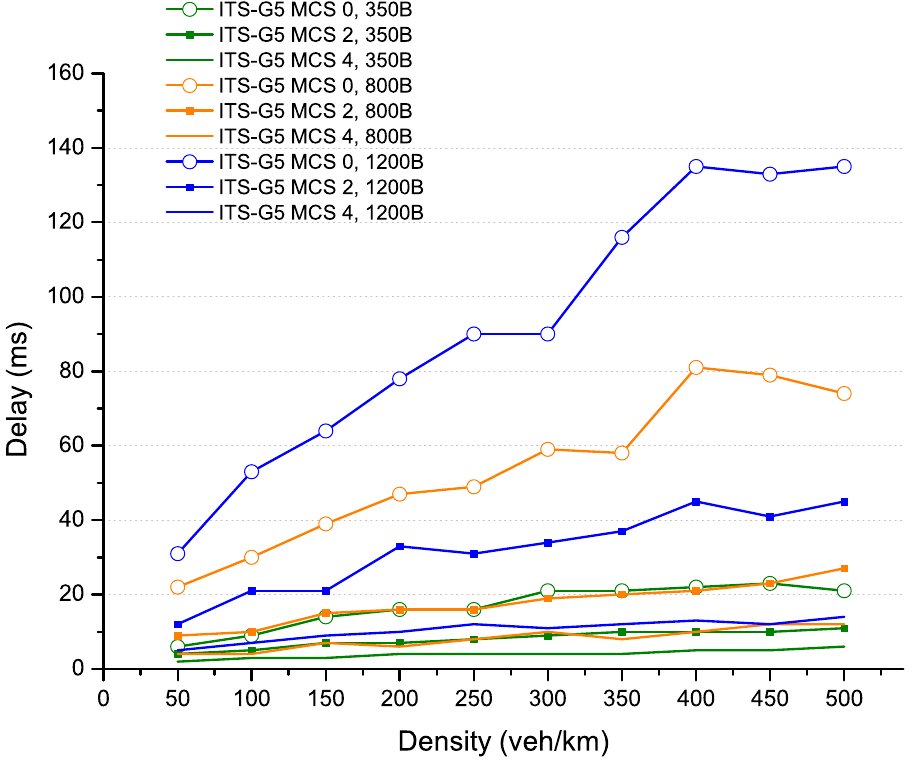
Figure 3. ITS-G5 packet delay for 100% of the generated packet.